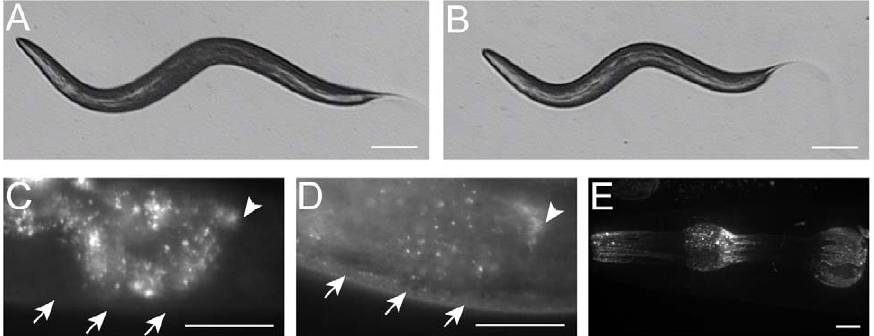
Figure 1. sma-10 is required for normal body size. Microscope images of (A) a wild-type (N2) hermaphrodite and (B) a sma-10(wk66) hermaphrodite, both taken at 24 hours after the L4/adult molt (same magnification on a dissecting microscope, scale bar represents 0.1 mm). SMA- 10:GFP is expressed in hypodermis (D) and pharynx muscle (E). No hypodermal fluorescence was detected in non-transgenic animals (C). Weak expression was detected in hypodermis (20-fold longer exposure of image in (C) than (D)). Arrows point to hypodermis in (C,D). Arrowheads point to the end of the intestine in (C,D). Intestinal autofluorescence is visible to the left of the arrowheads in (C,D). Strong expression of the SMA-10:GFP full- length fusion construct was observed in the pharynx muscle. Expression of the ttx-3::rfp marker in the AIY neuron is also visible in the upper right corner (E). Scale bars in (C–E) represent 0.01 mm. Anterior is to the left in all panels.